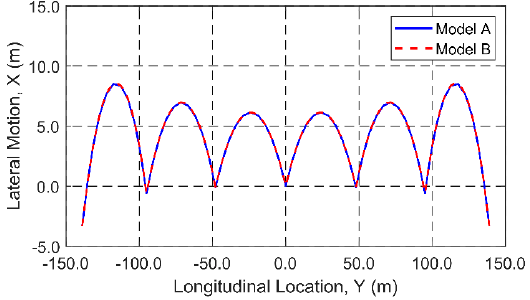
Figure 3. Envelopes of lateral motions (Z = − 23 m) of Model A and Model B at a current velocity of 0.6 m/s for the convergence test.